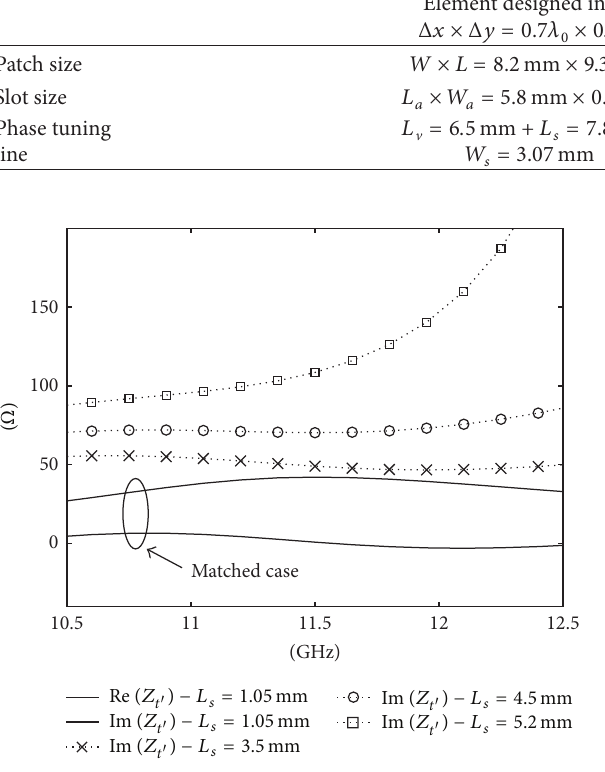
Figure 6: Input impedance 𝑍 𝑡 󸀠 for different stub lengths.